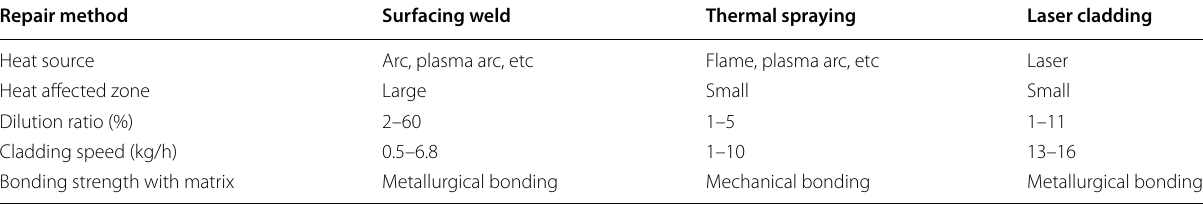
Table 1 Characteristics of common mold repair methods Repair